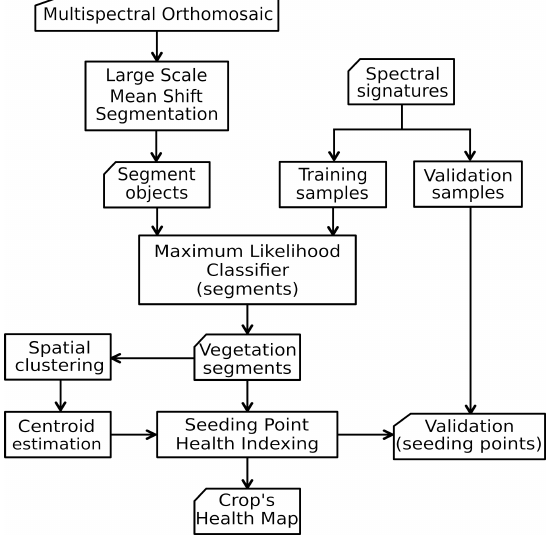
Figure 6. Proposed pipeline for obtaining seeding point health level maps from high resolution multispectral